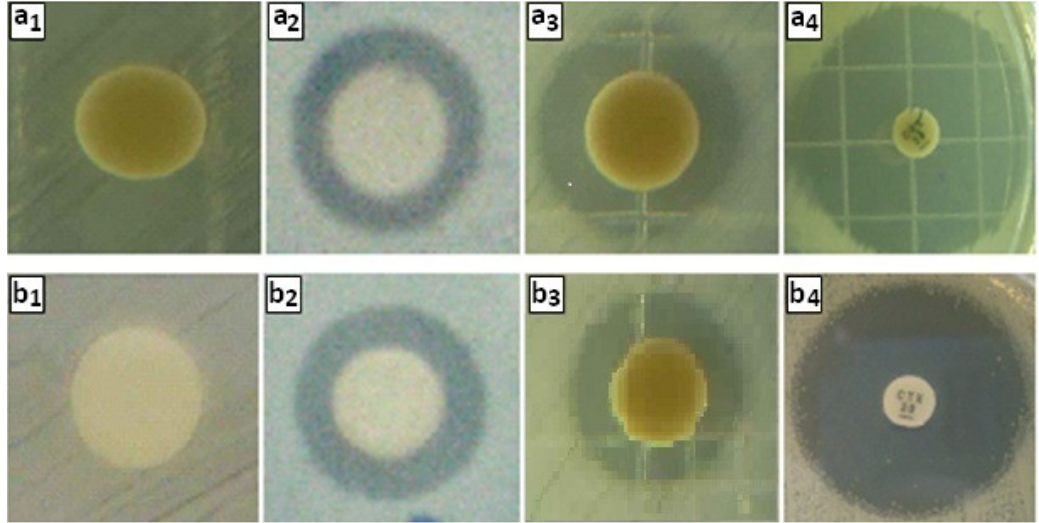
Figure 5. Antibacterial activity assay against E. coli (a Vitex negundo extract (0.5 mg/mL), (a negundo , (a